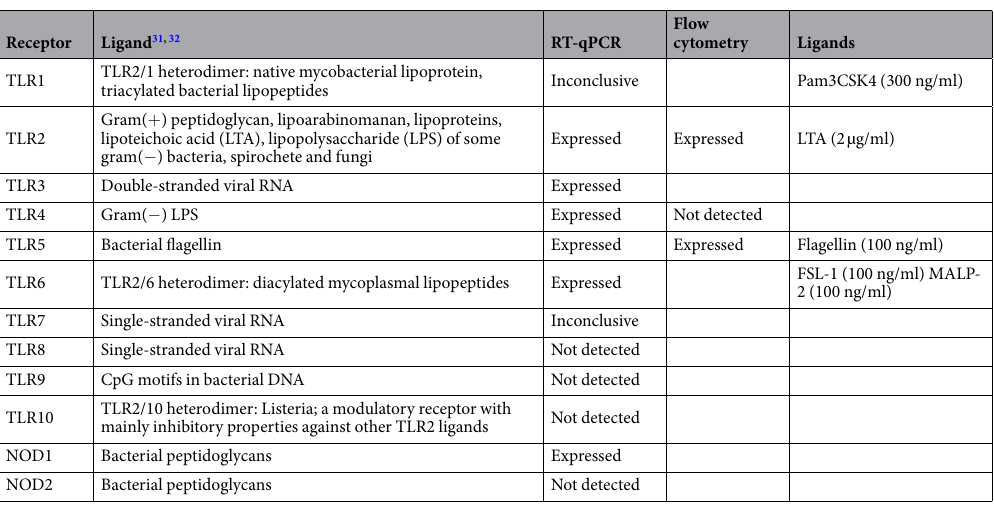
that NOD1 does not play a major role in this process (Supplementary Figure S6). To further test whether the biofilm-induced downregulation of ITGB6 could involve TLR2/6, we used specific function blocking antibod- ies against this receptor. Surprisingly, neither TLR2 nor TLR6 blocking antibodies (up to 20 µ g/ml) inhibited